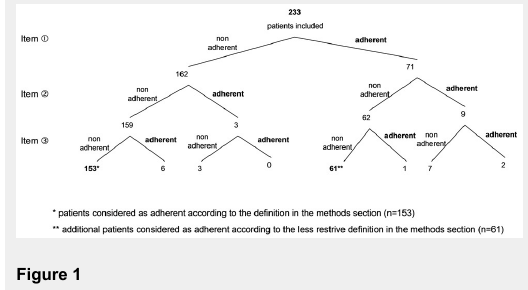
Responses given by the patients to the first three items of the